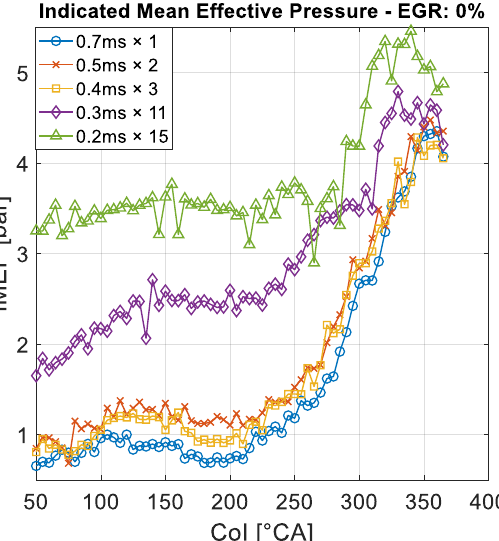
Figure 3. The IMEP of the investigated structures with the same dose in the function of CoI without EGR.